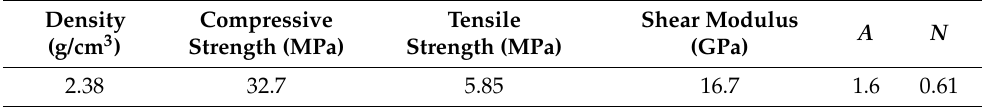
Table 4. Material parameters of concrete.